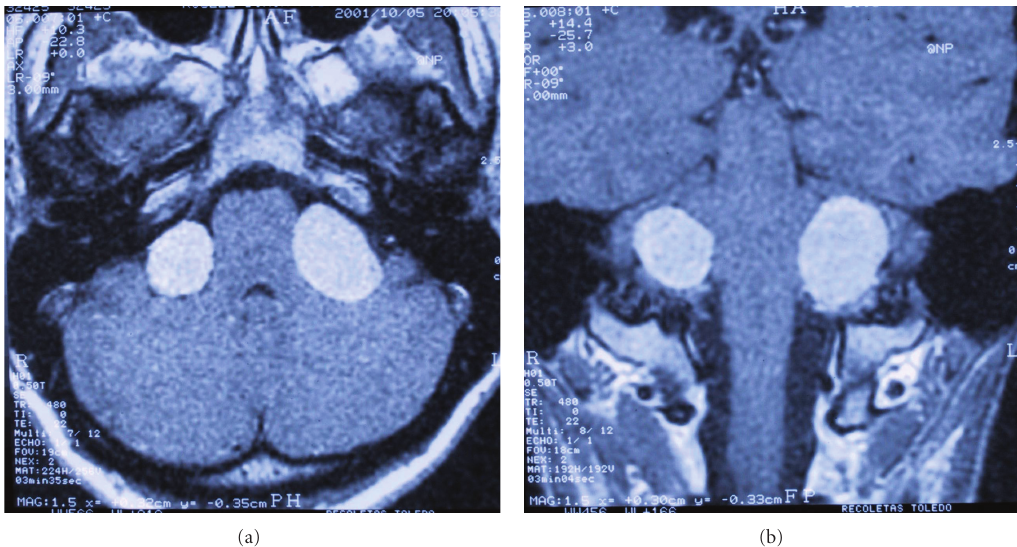
Figure 1: MRI axial and coronal view of neurofibromatosis type 2